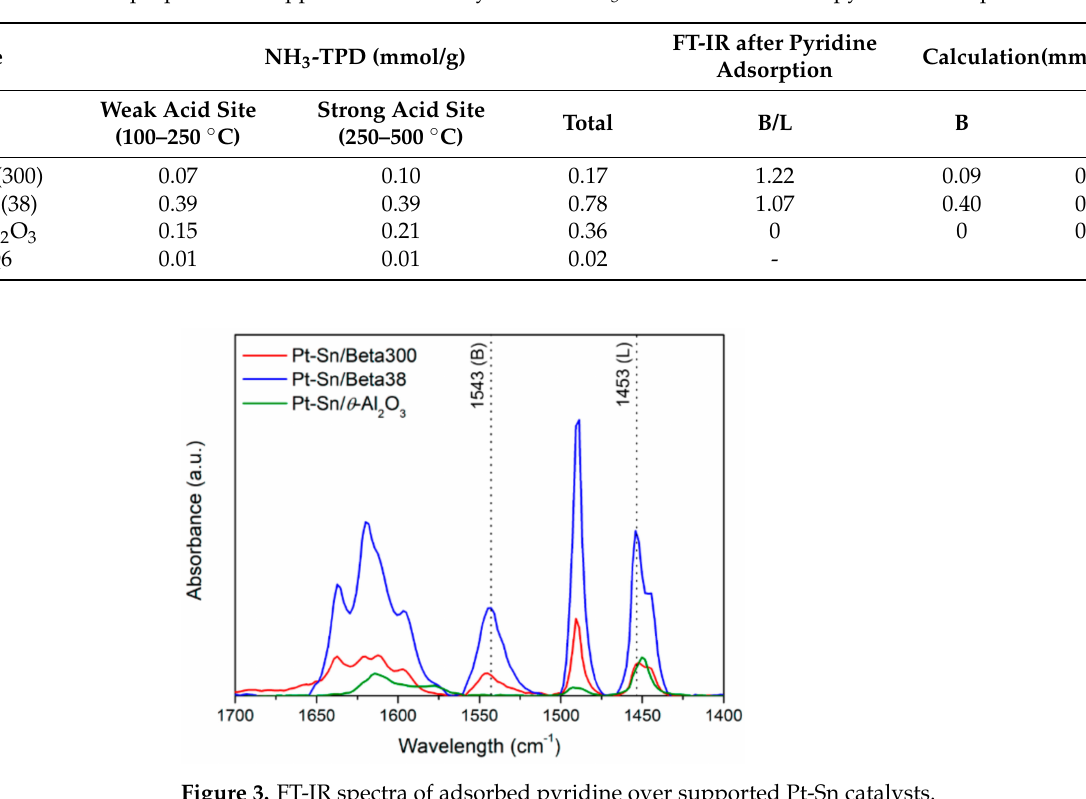
Figure 2. NH 3 -TPD profiles of supported Pt-Sn catalysts. Table 2. Acidic properties of supported Pt-Sn catalysts from NH 3 -TPD and FT-IR after pyridine adsorption.